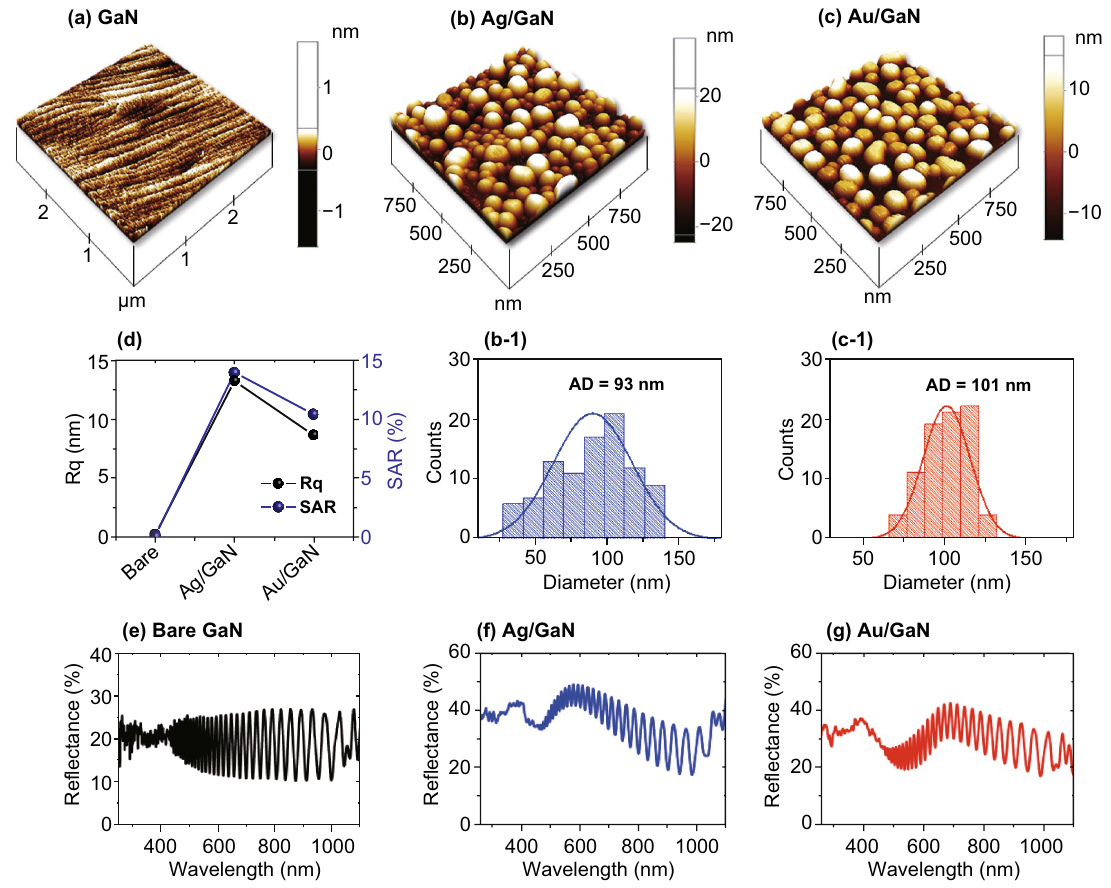
Fig. 2 Morphological and optical analysis of bare GaN, Ag, and Au samples. a – c AFM side‑views of the corresponding samples. b-1 , c-1 Diameter distribution histograms of the Ag and Au NPs on GaN. d Summary plots of Rq and SAR. e – g Reflectance spectra of bare GaN, Ag, and Au samples in the UV–VIS–NIR